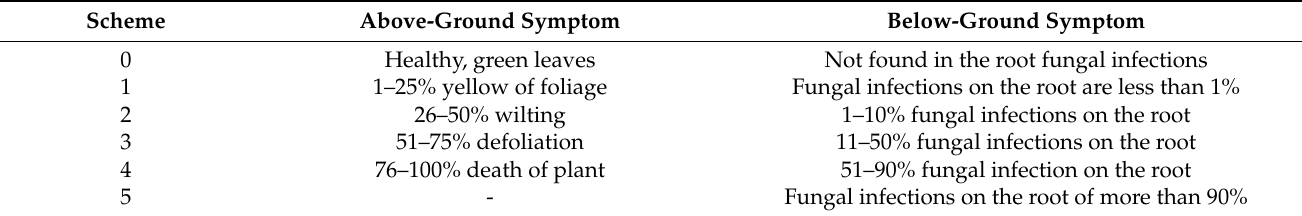
Table 2. Evaluation of disease severity scoring based on the observations of above- and below-ground symptoms. Scheme Below-Ground